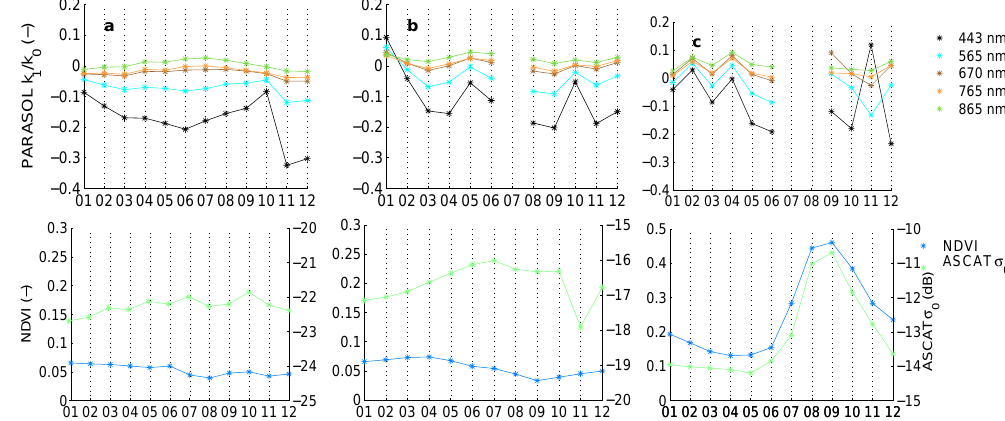
Fig. 2. Top panels: time series of the mean k 1 / k 0 for all PARASOL wavelengths, for the three regions selected on Fig. 1 – (a) – (c) , from left to right panels – for 2007. Lower panels: similar time series of the ASCAT response at 5.25GHz along with the